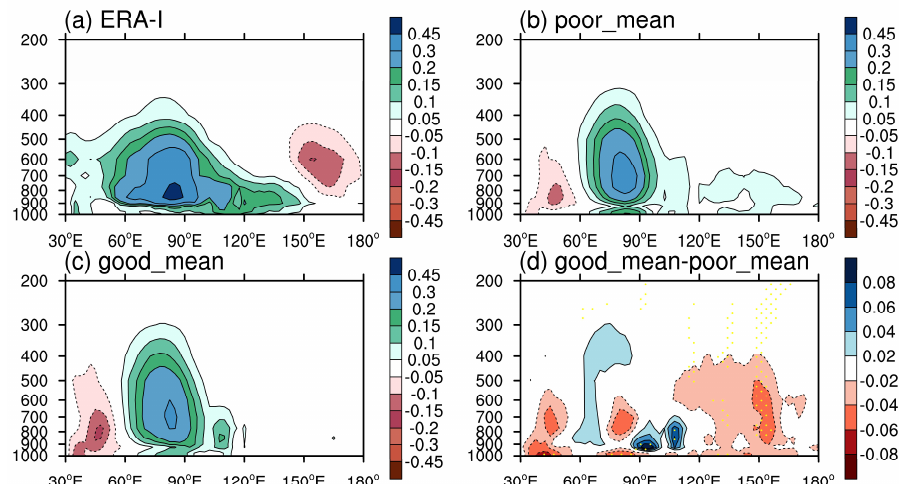
Figure 13. Longitude-height cross section of regressed specific humidity (averaged over 10 ◦ S–10 ◦ N) on lag day 0 against the area-averaged 20–100 day filtered OLR time series at the reference area (5 ◦ S–5 ◦ N; 75 ◦ –85 ◦ E) in ( a ) observation, ( b ) composite of poor simulations, ( c ) composite of good simulations and ( d ) di ff erence between composites of good and poor simulations where the di ff erences reaching 90% confidence level are dotted